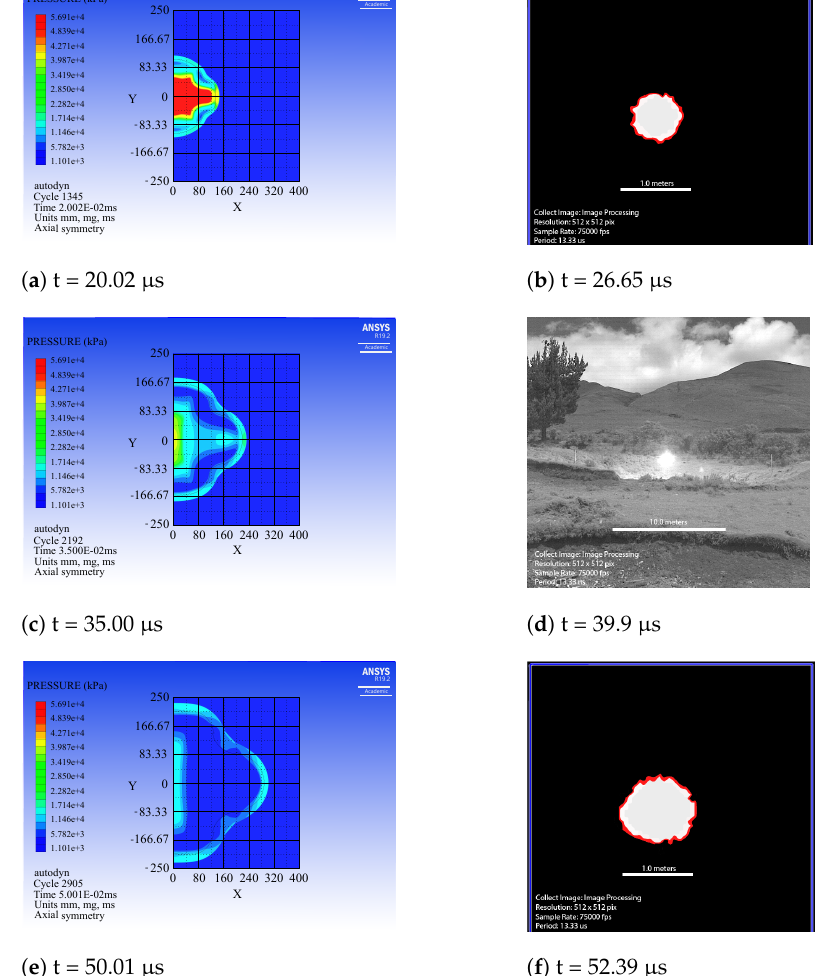
Figure 11. Numerical and experimental results for a cylindrical charge of 150 g of